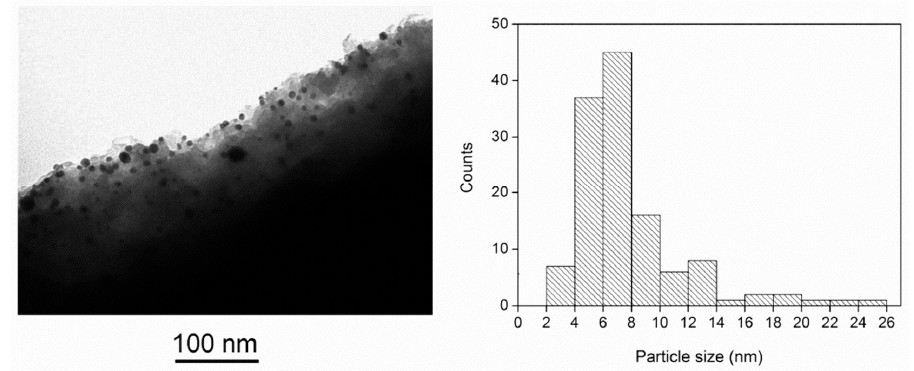
Figure 24. Transmission electron micrograph of Au@ZP-AEP ( left ) and Au particle size distribution ( right ). Adapted with permission from reference [111]. Copyright 2019, Royal Society of Chemistry.